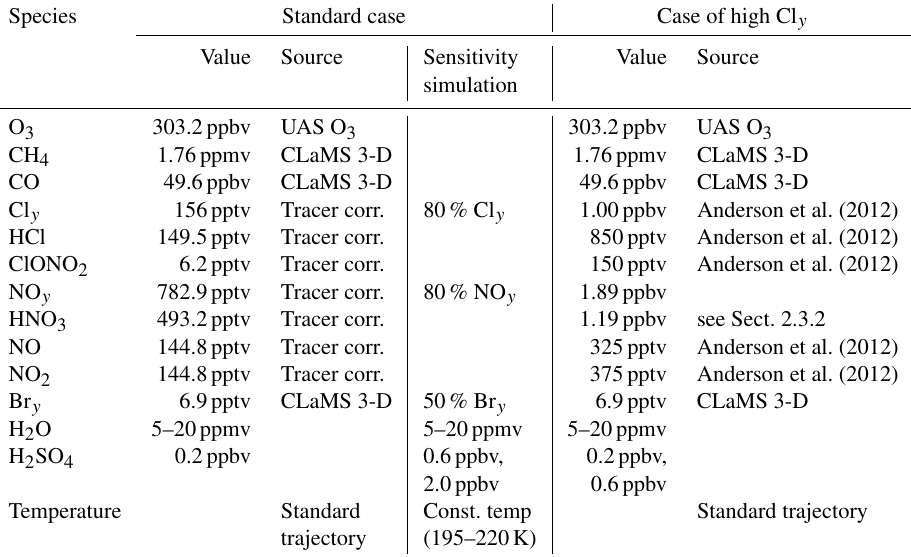
Table 1. Mixing ratios and sources used for initialization of relevant trace gases. The standard initialization is based on SEAC 4 RS measure- ments. Cl y and NO y values were determined based on tracer–tracer correlations (see Sect. 2.3.1). The high Cl y case is based on Fig. 2 from Anderson et al. (2012). Initial mixing ratios of ClO x species were assumed to be zero for all